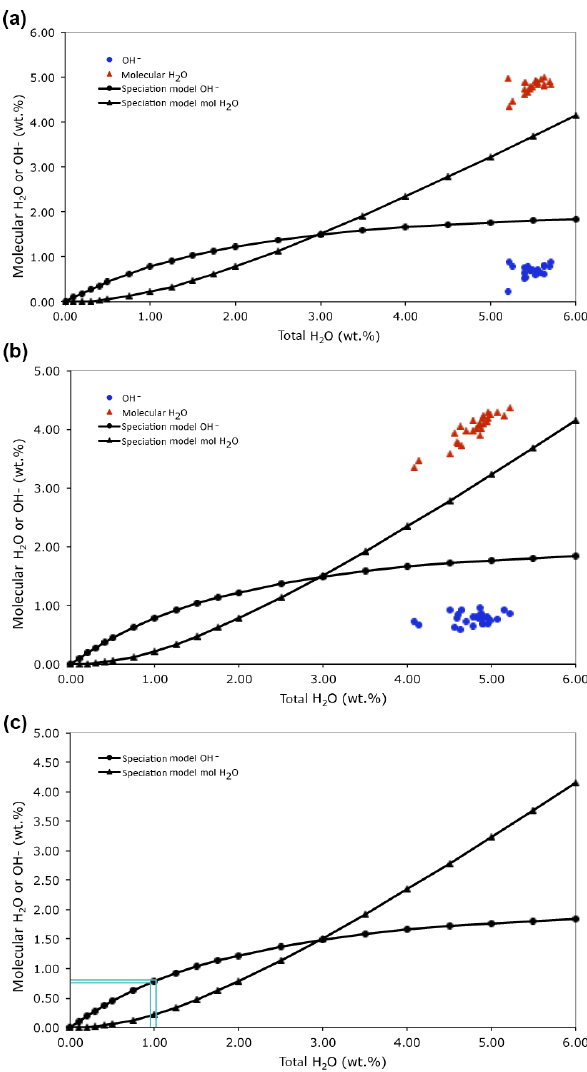
Figure 4. Speciation of water for bubble wall samples (a) TPRT1 and (b) TPRT2, plotted against the equilibrium speciation model for rhyolites of Zhang (1999). (c) Total magmatic water extrapo- lated from the OH − concentrations measured by FTIR using the equilibrium speciation model for rhyolites of Zhang (1999).